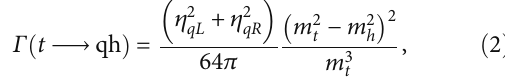
, hence the cross section is proportional to q . Since the PDF of valence u quarks are high, u